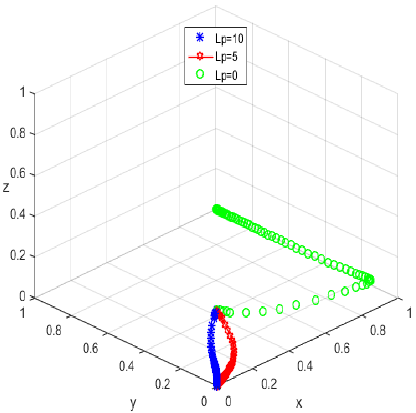
Figure 12. Trend graph for